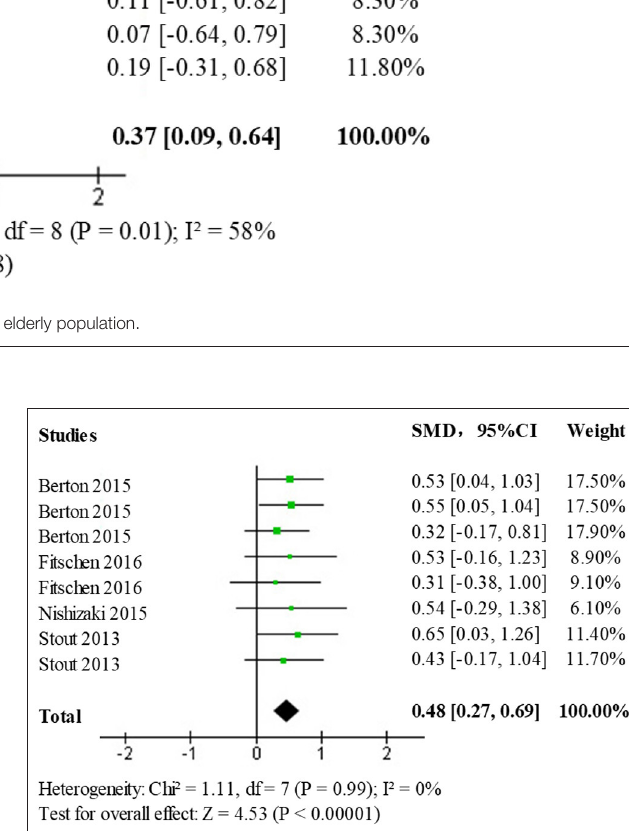
( p < 0.05) among the intervention vs. a control group of the elderly population with sarcopenia, the forest plot is shown in Figure 8 . This indicates that the intervention group had a more positive effect on overall muscle strength than the control group, suggesting that HMB improves the overall muscle strength of patients with